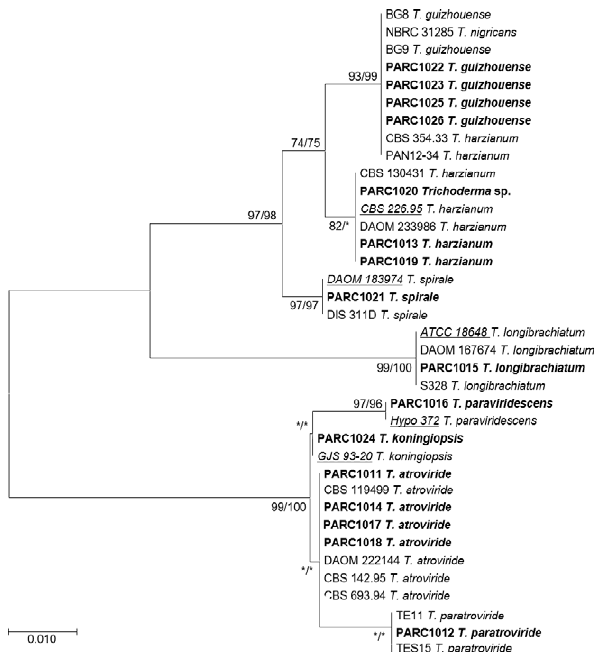
Figure 2. Greatest log likelihood EF-1α Neighbor-Join phylogenetic tree generated with 36 Trichoderma nucleotide sequences. Num- bers in before and after each slash (/) represent, respectively, likeli- hood and parsimony bootstrap values from 1,000 replicates. Values accompanied by asterisks were less than 70% bootstrap. Trichoder- ma isolates from southern Italy included in this study are indicated in bold. Ex-type isolates are indicated in underlined italics.